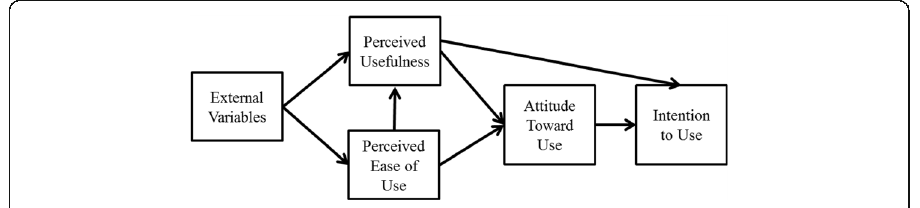
Fig. 1 Technology Acceptance Model (adapted from Davis, Bagozzi & Warsaw,